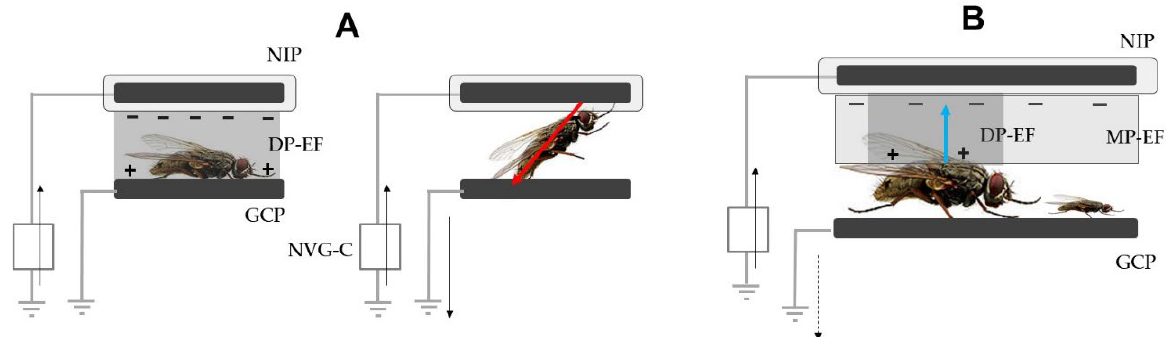
* Refer to Table 1 for the abbreviations of insect names. Insect species are ordered from top (smallest) to bottom (largest) according to their body sizes. ** bridge is formed by an inset body between the NIP and GCP. Twenty insects were used for each voltage and each species. The means ± standard deviations were calculated from five experimental replicates. The different letters (a–d) within a column indicate significant differences ( p < 0.05) according to Tukey’s test. The attractive force of the instrument (5 mm interval) was sufficient to draw large insects (houseflies and greenbottle flies) to the NIP at >–8 kV. However, their capture was considered abnormal because a bridge was established between the opposite poles by the insect body, which was large enough to touch both poles (Figure 7A) (Video S3A). In this case, the flies formed a direct route for the electric current to flow between the opposite poles. The current flow erased the surface accumulation of negative charge (i.e., loss of attractive force) and eventually caused the insulating coating to break down.